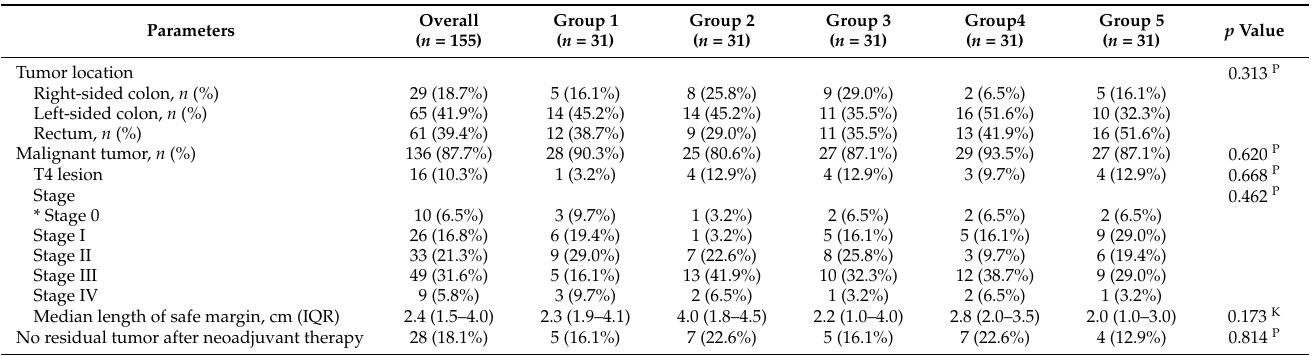
Table 3. Tumor histopathological